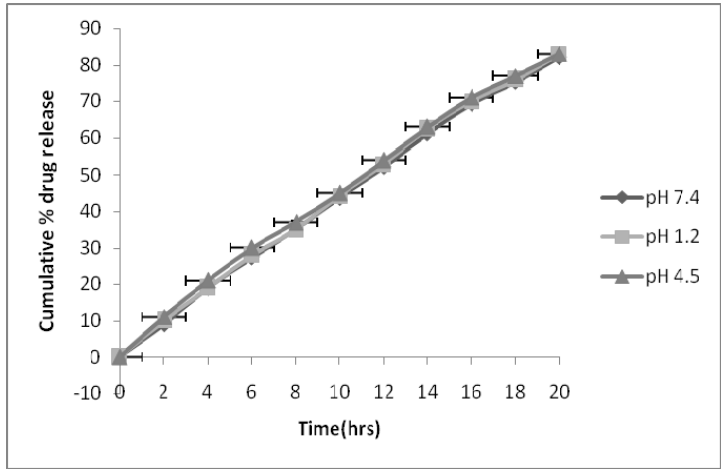
Figure 3. Effect of pH on drug release from optimized formulation.